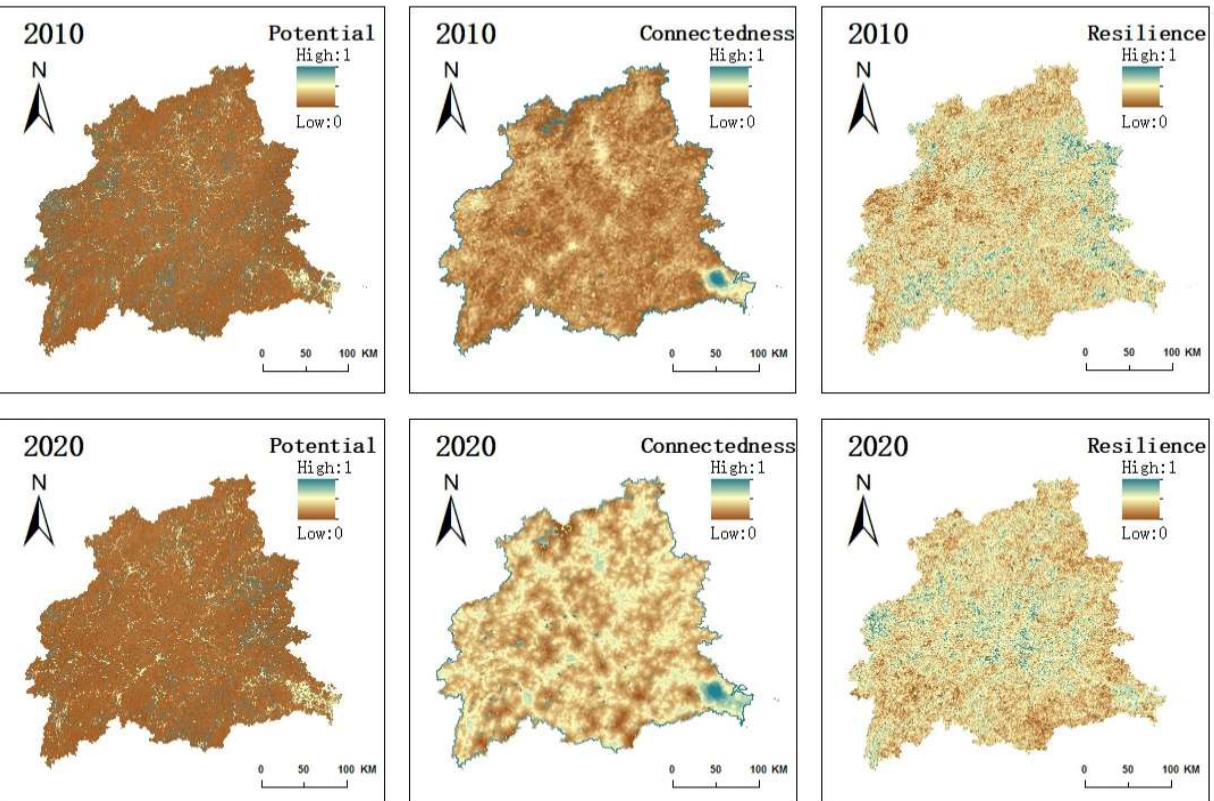
Figure 7. Spatial and temporal distribution of the risk values of “potential- connectivity-resilience”